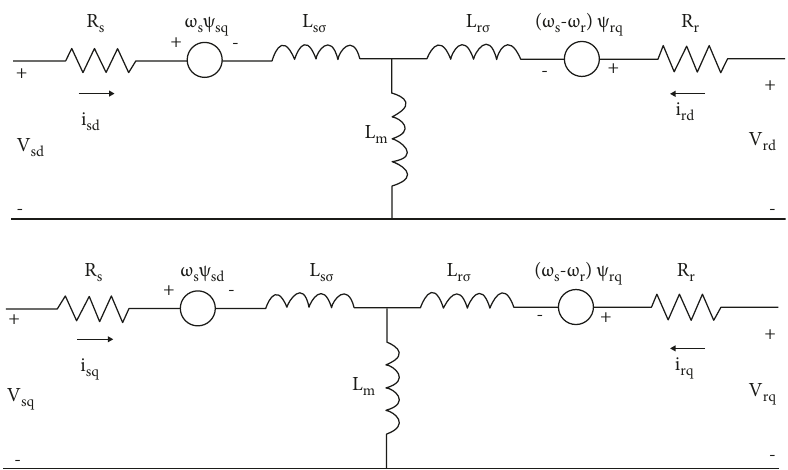
Figure 2: DFIG equivalent circuit [19].